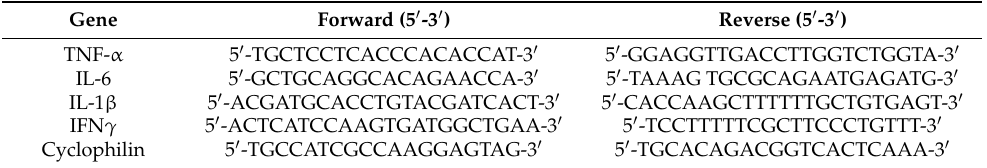
Table 1. Primer sequences for real-time